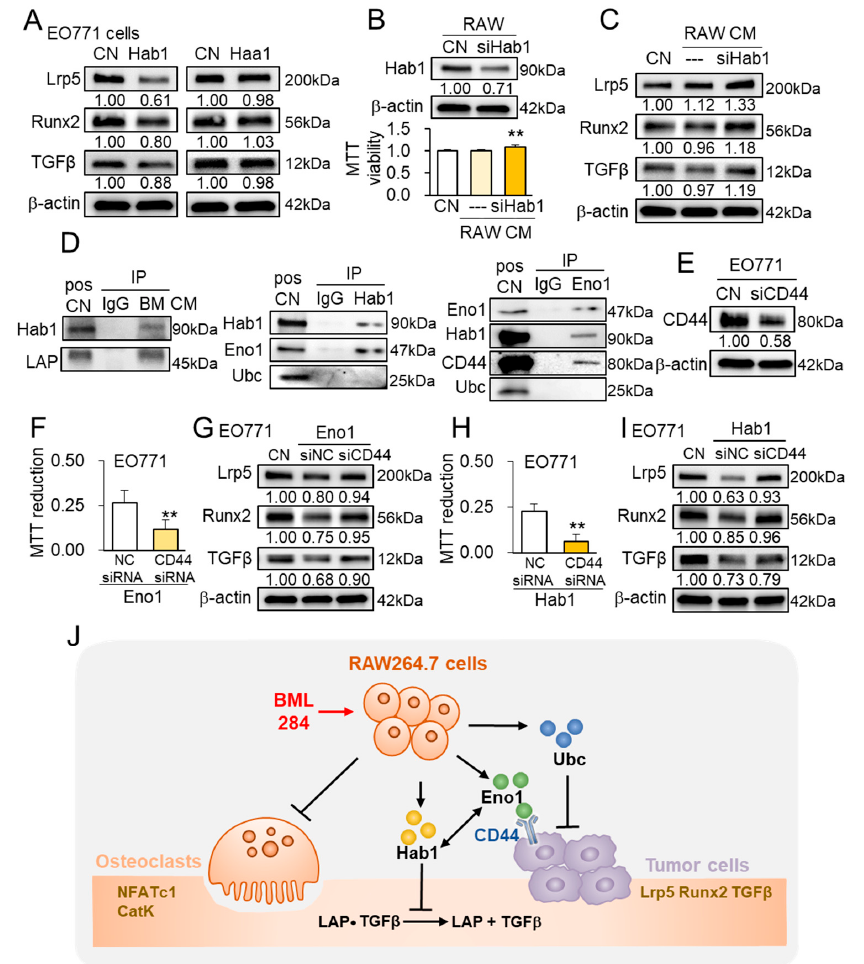
Figure 8. Inhibitory action of Hsp90ab1 and Eno1. Hab1 = Hsp90ab1, Haa1 = Hsp90aa1, siHab1 = Hsp90ab1 siRNA, CN = control, and BM CM = BML284-treated RAW264.7-derived CM. ** p < 0.01. ( A ) Expression of Lrp5, Runx2, and TGF β in response to Hsp90ab1 and Hsp90aa1in EO771 cells. ( B ) Elevation of MTT-based viability of EO771 cells in response to Hsp90ab1 siRNA-treated, RAW276.4-derived CM. ( C ) Expression of Lrp5, Runx2, and TGF β in response to Hsp90ab1 siRNA-treated, RAW276.4-derived CM. ( D ) Co-immunoprecipitation of LAP (latency-associated peptide) TGF β by Hsp90ab1 in BM CM, Eno1 by Hsp90ab1, Hsp90ab1 by Eno1, and CD44 by Eno1 in EO771 cells. ( E , F ) Suppression of Eno1-mediated inhibition of the proliferation of EO771 cells by RNA silencing of CD44. ( G ) Suppression of Eno1-mediated downregulation of Lrp5, Runx2, and TGF β in EO771 cells by RNA silencing of CD44. ( H , I ) Suppression of Hab1-mediated inhibition of the proliferation, and downregulation of Lrp5, Runx2, and TGF β of EO771 cells by RNA silencing of CD44. ( J ) Schematic illustration of the possible regulatory mechanism with BML284-treated RAW264.7 osteoclast-derived CM (BM